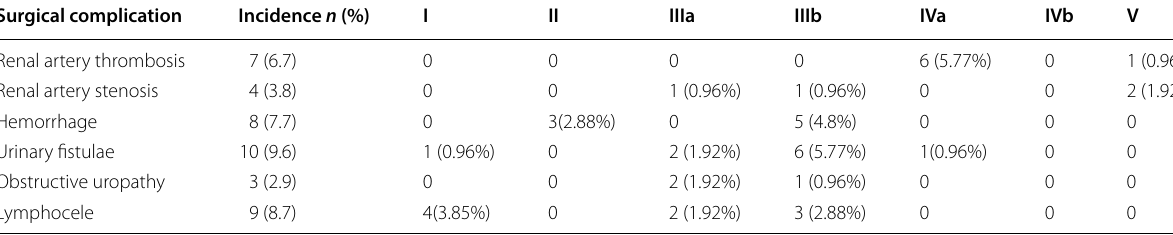
Table 2 Surgical complications reporting by Calvien–Dindo grading system Surgical complication